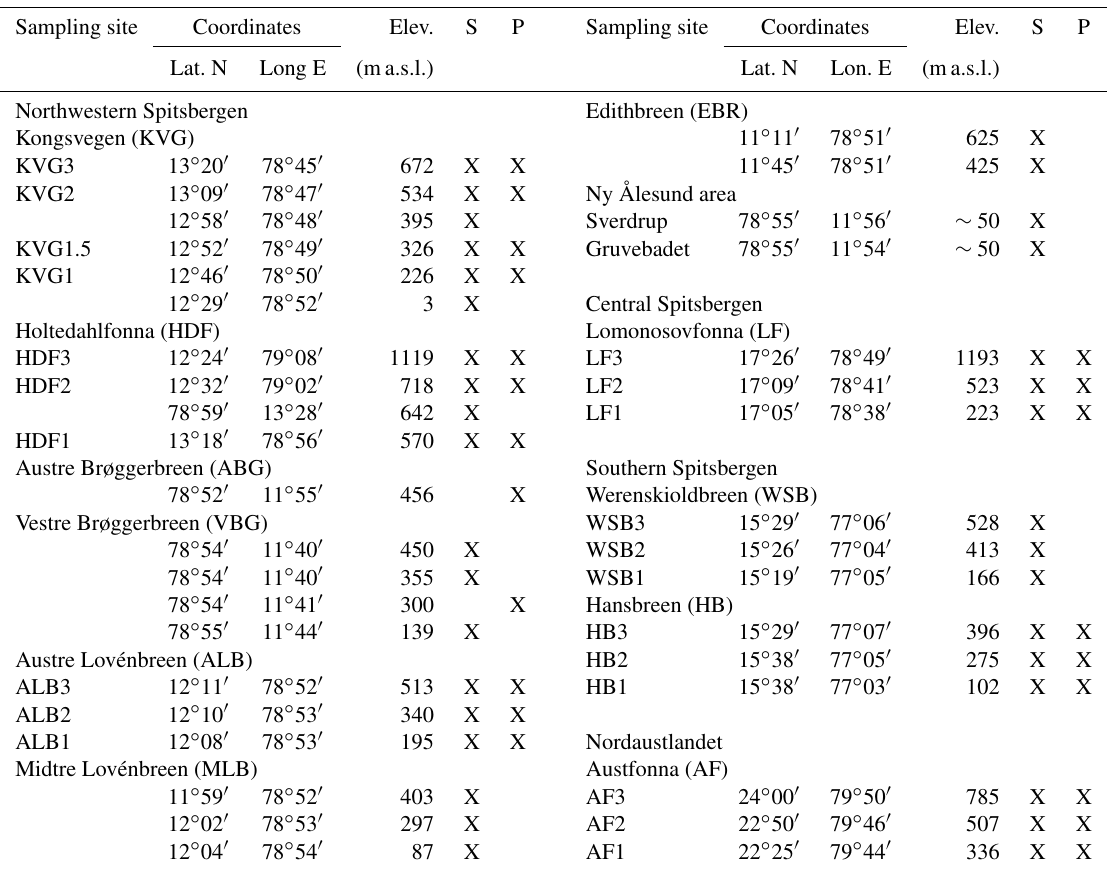
Table 2. Snow sampling sites in Svalbard mentioned in this paper. Glacier site codes that include a number (e.g., KVG3) are those where samples were collected during the spring 2016 survey. The “x” symbols indicate whether samples were collected from surface layers (S) and/or in snowpits (P). A few samples from Austre Brøggerbreen (ABG) were collected below 456ma.s.l. Further details on sampling sites are provided in Tables S1 and